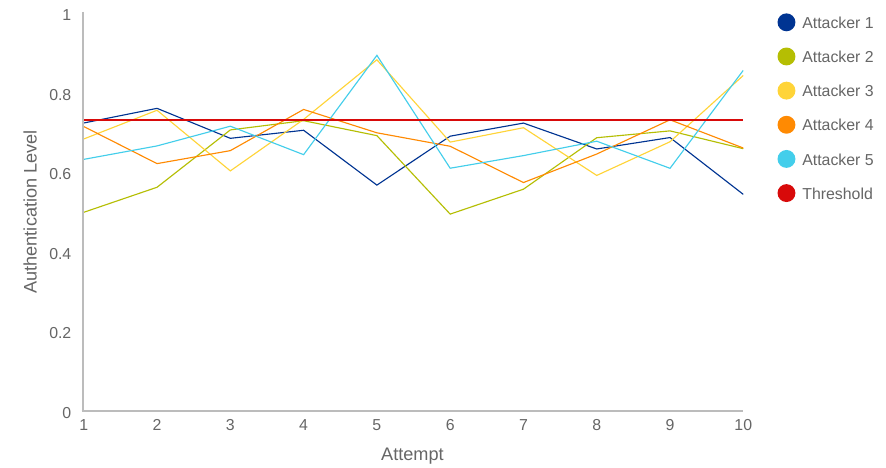
Figure 10. Shoulder surfing attack